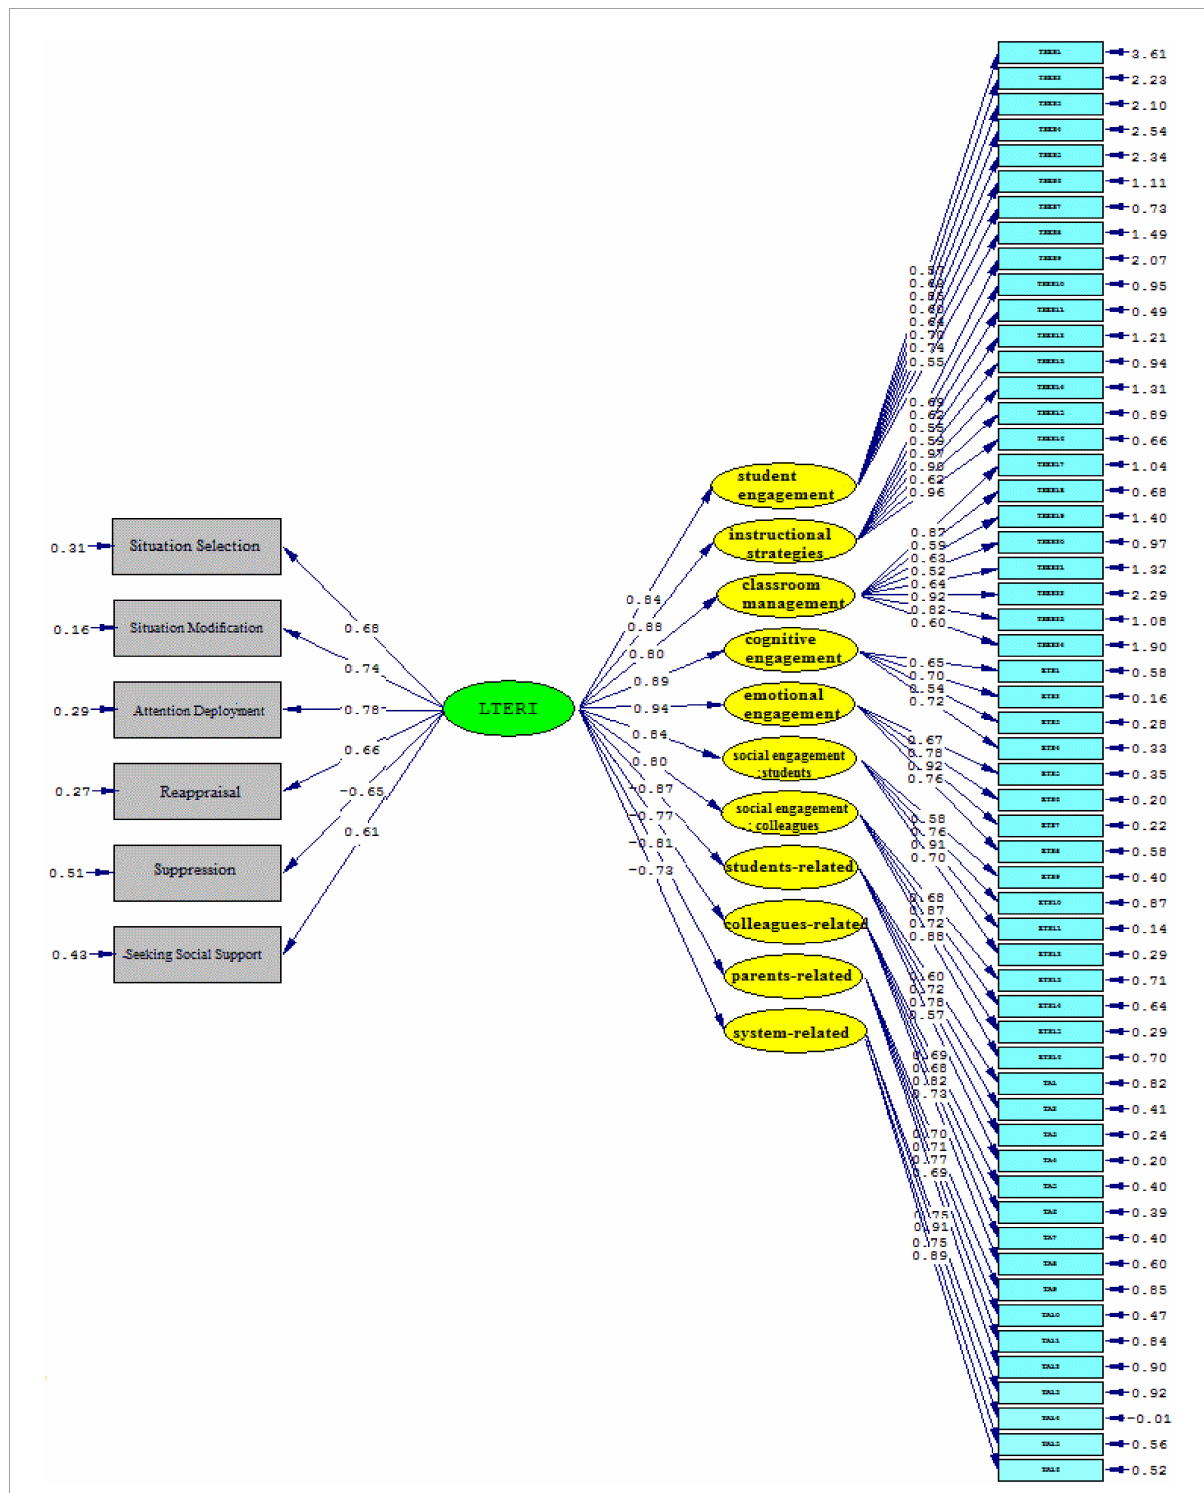
FIGURE4 The schematic representation of path coefficient values (Model